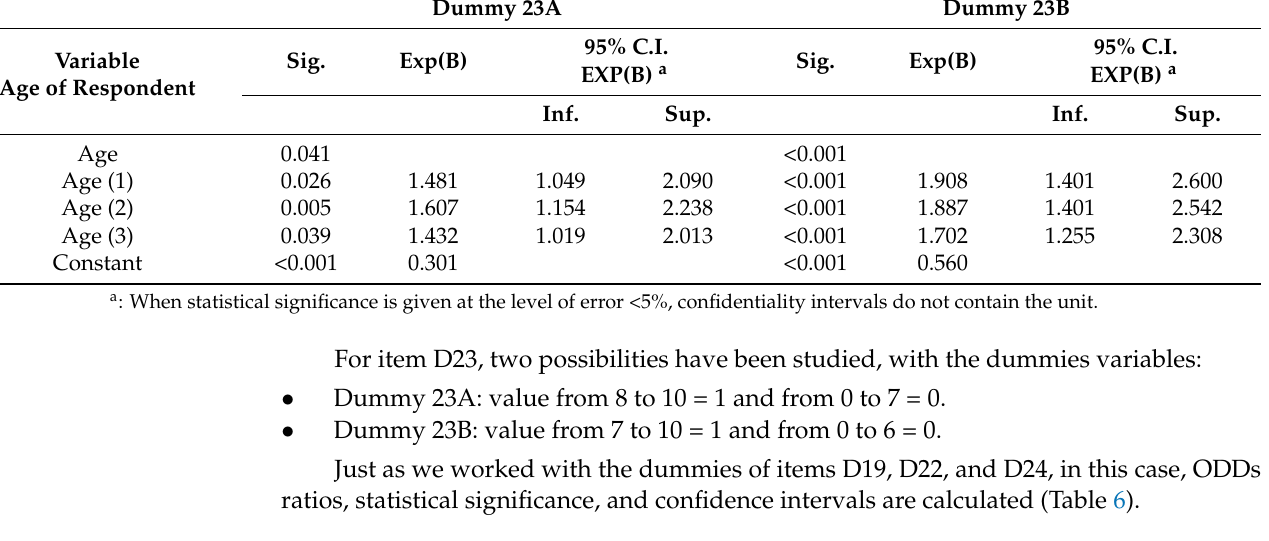
Table 6. Parameters for a relationship between item D23 and age of respondent (age category of reference: 4). Dummy